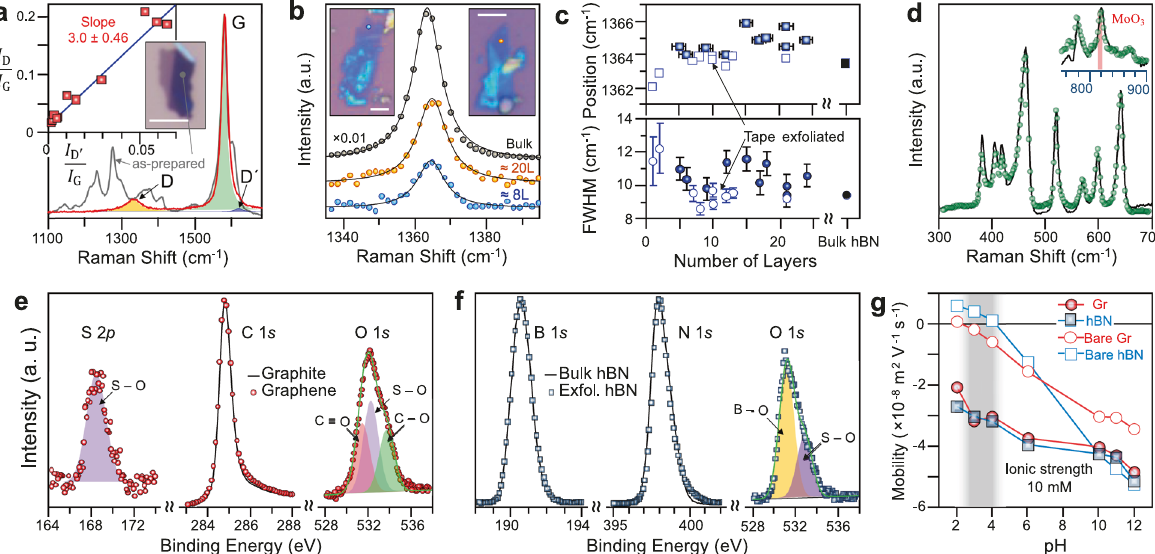
Fig. 3 Crystal quality and non-covalent functionalisation of the 2D sheets. a Raman spectrum of the as-prepared (grey trace) and annealed at 1100 °C (red trace) graphene 2D sheets. Inset: Intensity ratio I D = I G versus I D 0 = I G measured for the annealed graphene obtained from fi tting three Lorentzian functions to the spectrum. The data are approximated by a linear dependence with a slope close to three 29 . b Raman spectra of bulk hBN and annealed hBN 2D sheets (circles) and the Lorentzian approximation used to fi nd the position and width of the E 2g mode 30 . The micrographs in the insets to a , b show the position of the laser spot. Scale bars: 3 μ m. c The comparison of the peak position (squares) and FWHM (circles) as a function of the number of layers for the tape exfoliated (open symbols) and acid-assisted exfoliated 2D sheets (light blue symbols) vs. bulk particles (solid symbols). Error bars represent one standard deviation. d Raman spectra of the tape exfoliated (black trace) and acid-assisted exfoliated 2D sheets (green circles) of MoS 2 . Inset: The spectrum at around 820 cm − 1 attributed to the molybdenum oxide 31 . e The XPS spectrum of graphene (red circles) and graphite (black trace) highlighting the sulfur 2 p , carbon 1 s , and oxygen 1 s levels. f The XPS spectrum of the exfoliated hBN (black squares) and bulk hBN (black curves) highlighting boron 1 s , nitrogen 1 s , and oxygen 1 s levels. The oxygen 1 s peaks in e , f were deconvoluted to extract the relative contribution from sulfur bound oxygen. g Electrophoretic mobility of LPE (open symbols) and acid-assisted exfoliated (solid symbols) for graphene (circles) and exfoliated hBN (squares) in the water at different pH. The vertical grey band highlights the isoelectric region for LPE 2D